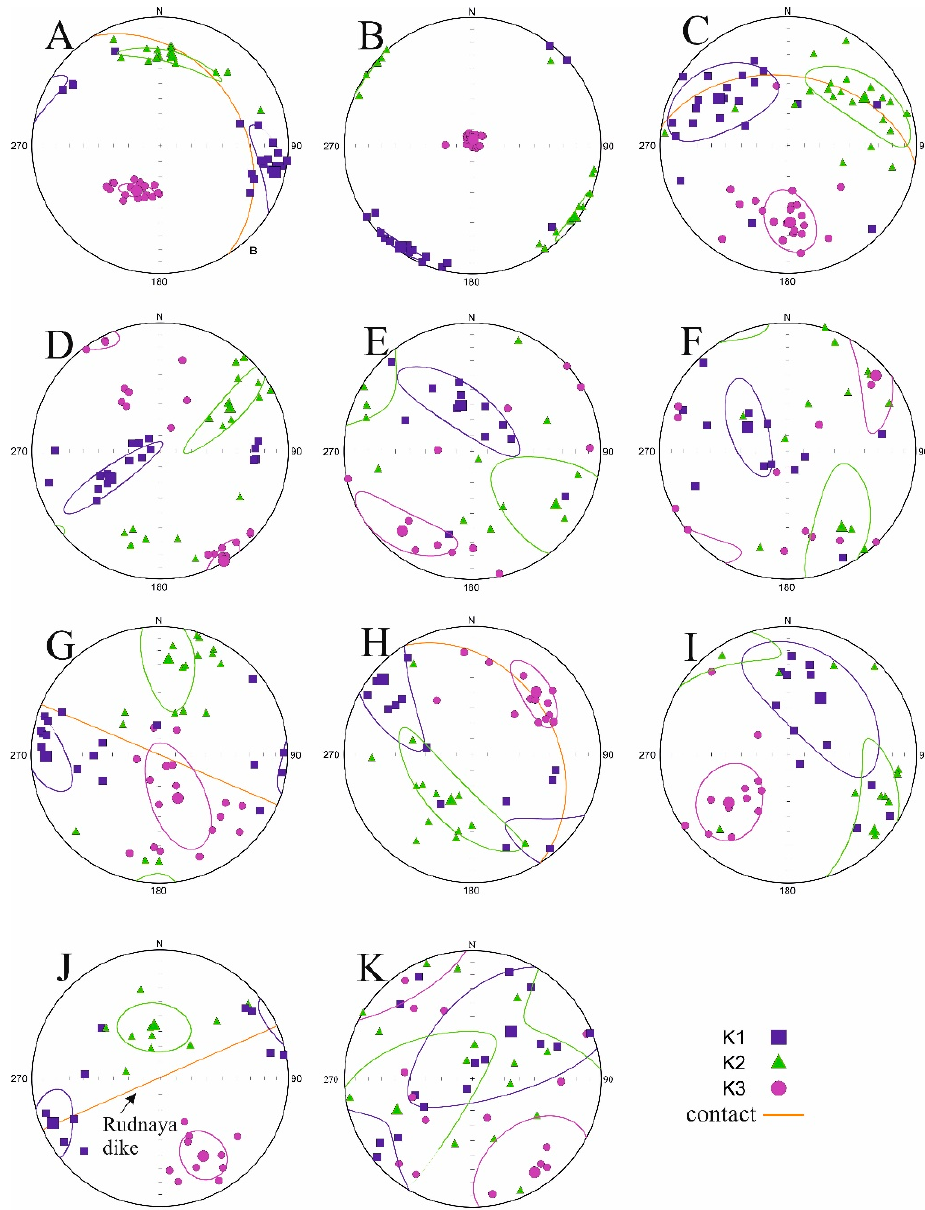
Figure 4. Examples of AMS ellipsoids for sites with various magnetic fabrics. Geographic coordinate system. ( A ) Site mk7_19, Mokulaevsky Formation, basaltic lava flow, N-type. ( B ) Site 11.2_17, Oganer sill, gabbro-dolerites, N-type. ( C ) Site 12.2_17, intrusion of Zayachiy Creek, leucogabbro, N-type. ( D ) Site 19_19, Ruinnaya intrusion (Morongovsky complex), gabbro-dolerites, R-type. ( E ) Site 49_17, Talnakh intrusion, gabbro-dolerites, R-type. ( F ) Site 7–16, sill of the Yergalakhsky complex, trachydolerites, R-type. ( G ) Site 24_18, dike of the Avamsky complex, dolerites, I-type. ( H ) Site mk10_19, Mokulaevsky Formation, basaltic lava flow, I-type. ( I ) Site 16_17, hornfels from the contact of the Kharaelakh intrusion, D-type. ( J ) Site I1, basalts of the Tuklonsky Formation nearby the Rudnaya dike, D-type. ( K ) Site AR3, Arylakh intrusion, gabbro-dolerites,